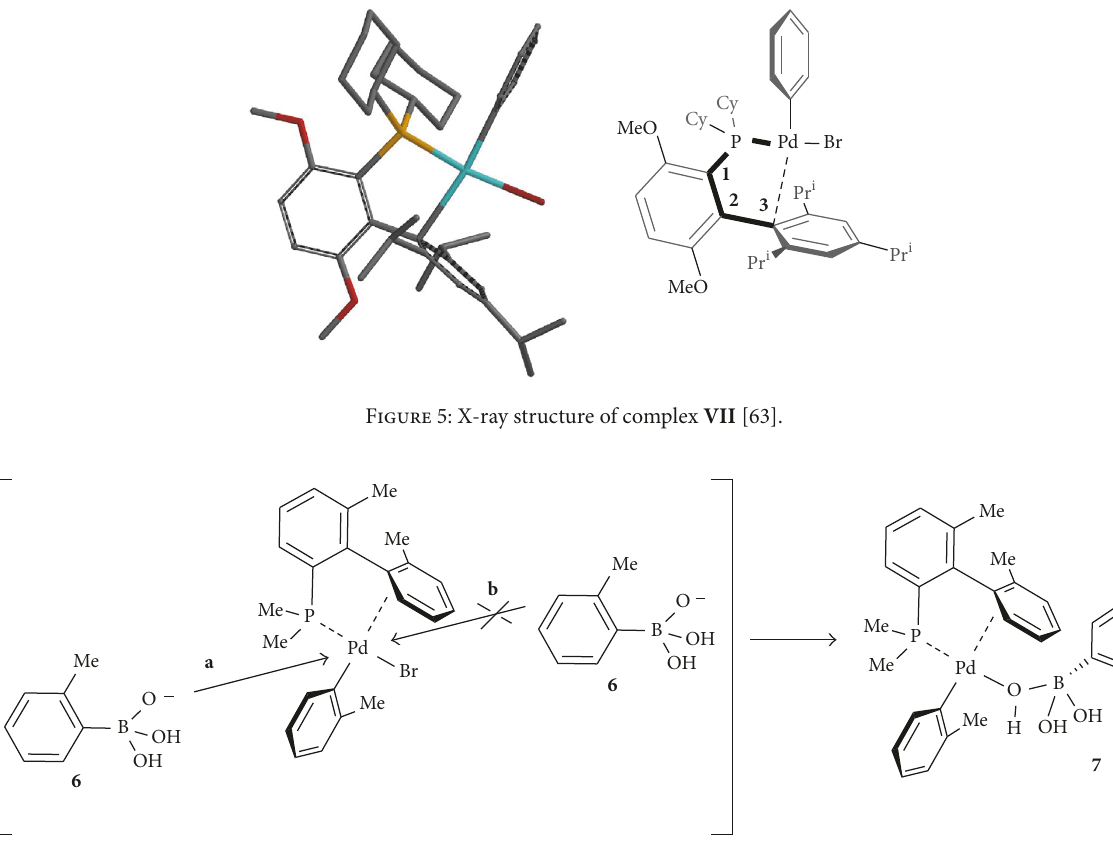
Scheme 5: Two possible paths of transmetallation.